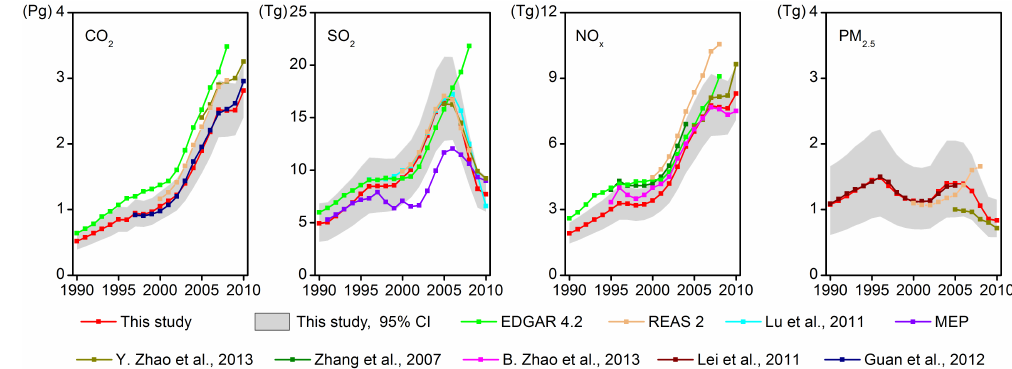
Figure 12. Comparisons of SO 2 , NO x , PM 2 . 5 and CO 2 emissions from China’s coal-fired power plants during 1990 and 2010.